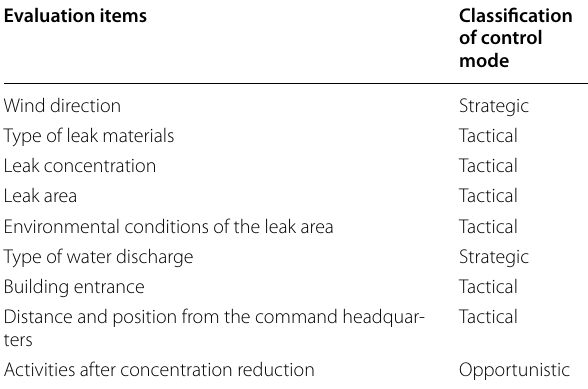
Table 4 Classification of the evaluation items for an attenuation activity